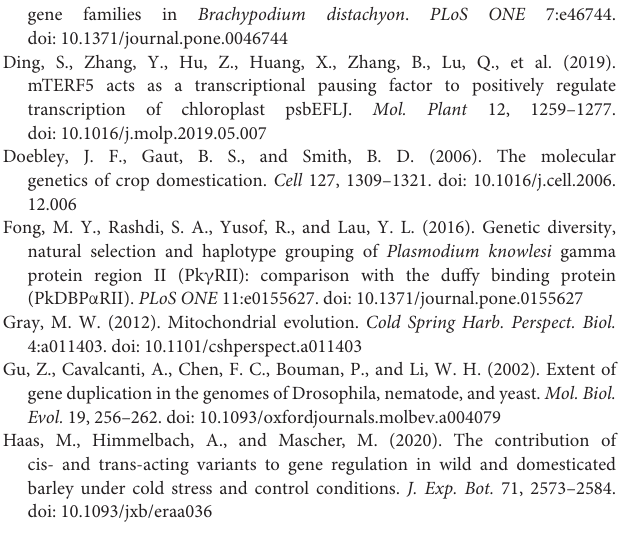
Supplementary Table 13 | Distribution of SNPs within various genomic regions. Supplementary Table 14 | Tracy-Widom (TW) statistics and P -values for the first 10 eigenvalues in the PCA of HvmTERF -related SNPs. Supplementary Table 15 | The number of HvmTERF s from different barley